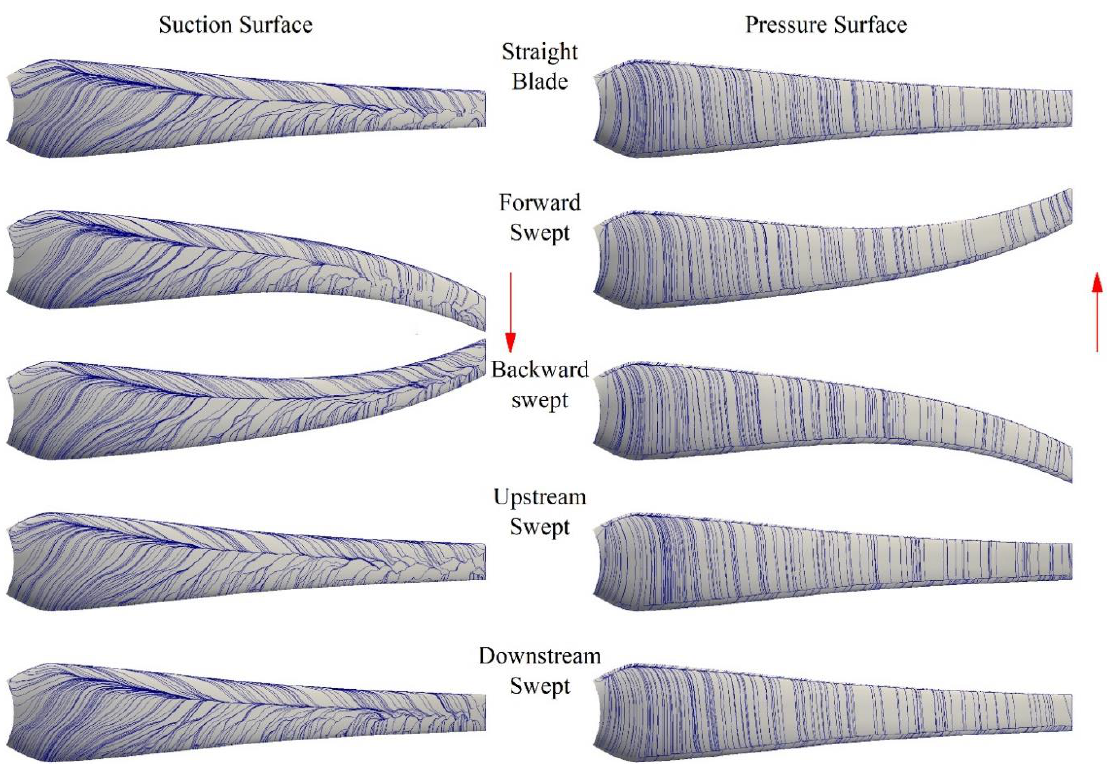
Figure 11. Surface streamlines above the straight blade and swept blades at TSR = 9, with the red arrows being the directions of the blades’